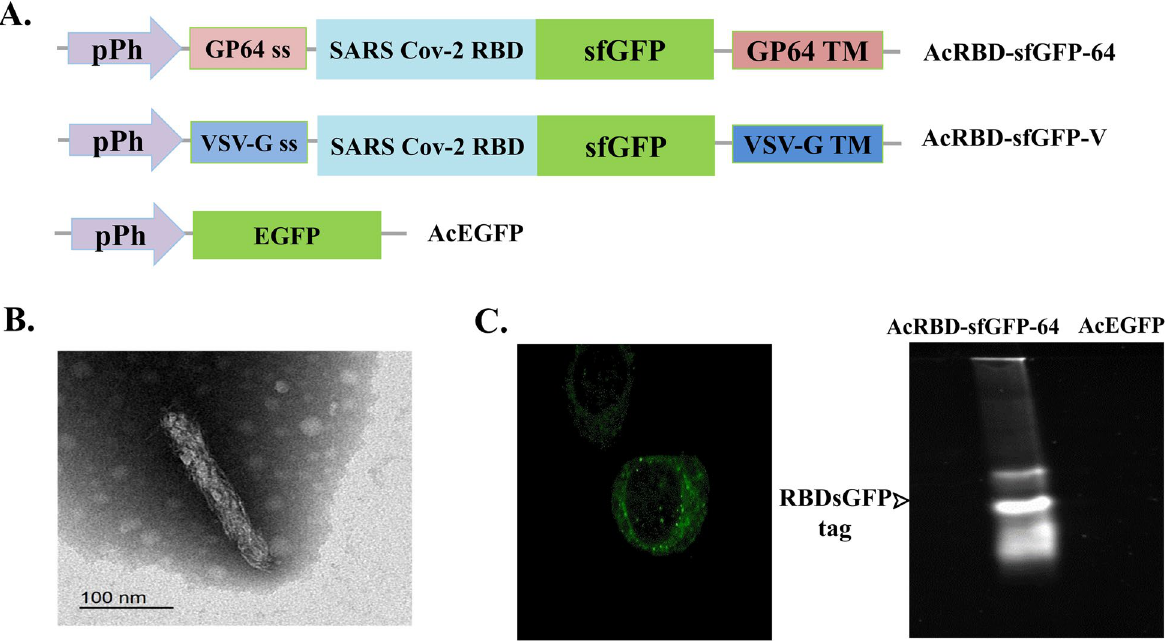
Fig. 1 Production of pseudotyped baculovirus displaying the RBD-sfGFP based on gp64 and VSV G-proteins. a Schematic map for bacmids constructs; all constructs were under polyhedrin promoter (Pph). b TEM of AcRBD-sfGFP-64 showing a rod-shaped budded virus (BV) 30–70 nm in diameter and 200–400 nm in length. c Validation of the function of the displayed protein by showing fluorescence on Sf9 cell periphery and ER using fluorescence microscopy under 60 objective and with in-gel ×